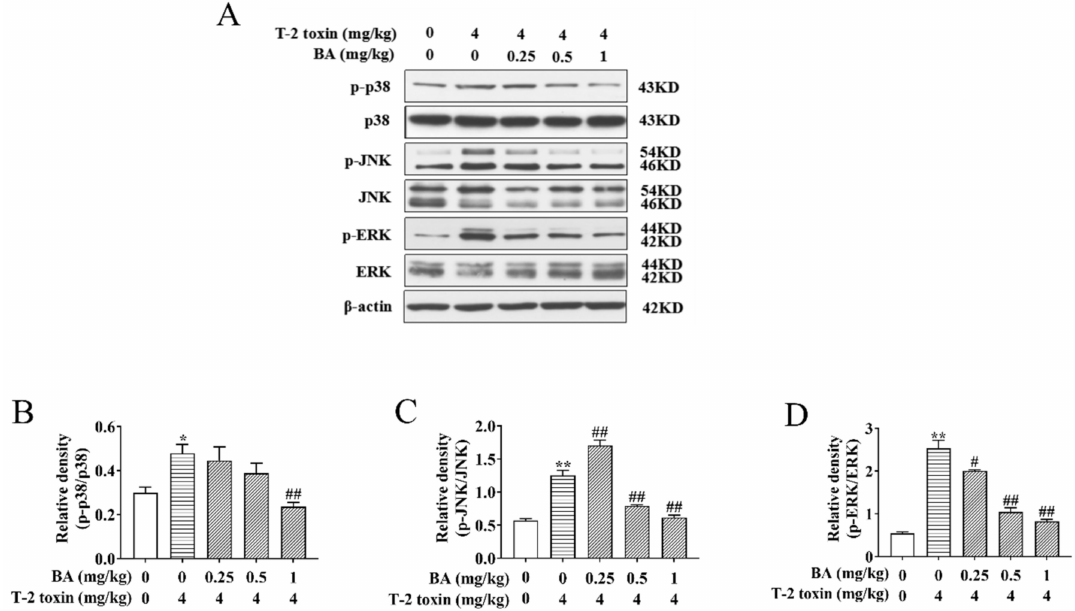
Figure 5. Effects of BA on the relative proteins expression of the mitogen-activated protein kinase (MAPK) signaling pathway in the spleen of T-2 toxin-intoxicated mice. The protein expression and phosphorylation of ERK, JNK, and p38 were evaluated by Western blot ( A ). Protein bands for each region were quantified, and the intensity was normalized to the intensity of the β -actin band present on the same blot. The values were expressed as the ratios of p-p38/p38 ( B ), p-JNK/c-Jun N-terminal kinase (JNK) ( C ), and p-ERK/extracellular signal-regulated kinases (ERK) ( D ). Data were presented as the mean ± SEM (3 mice per group). * p < 0.05 and ** p < 0.01 vs. the control group. # p < 0.05 and ## p < 0.01 vs. the T-2 toxin